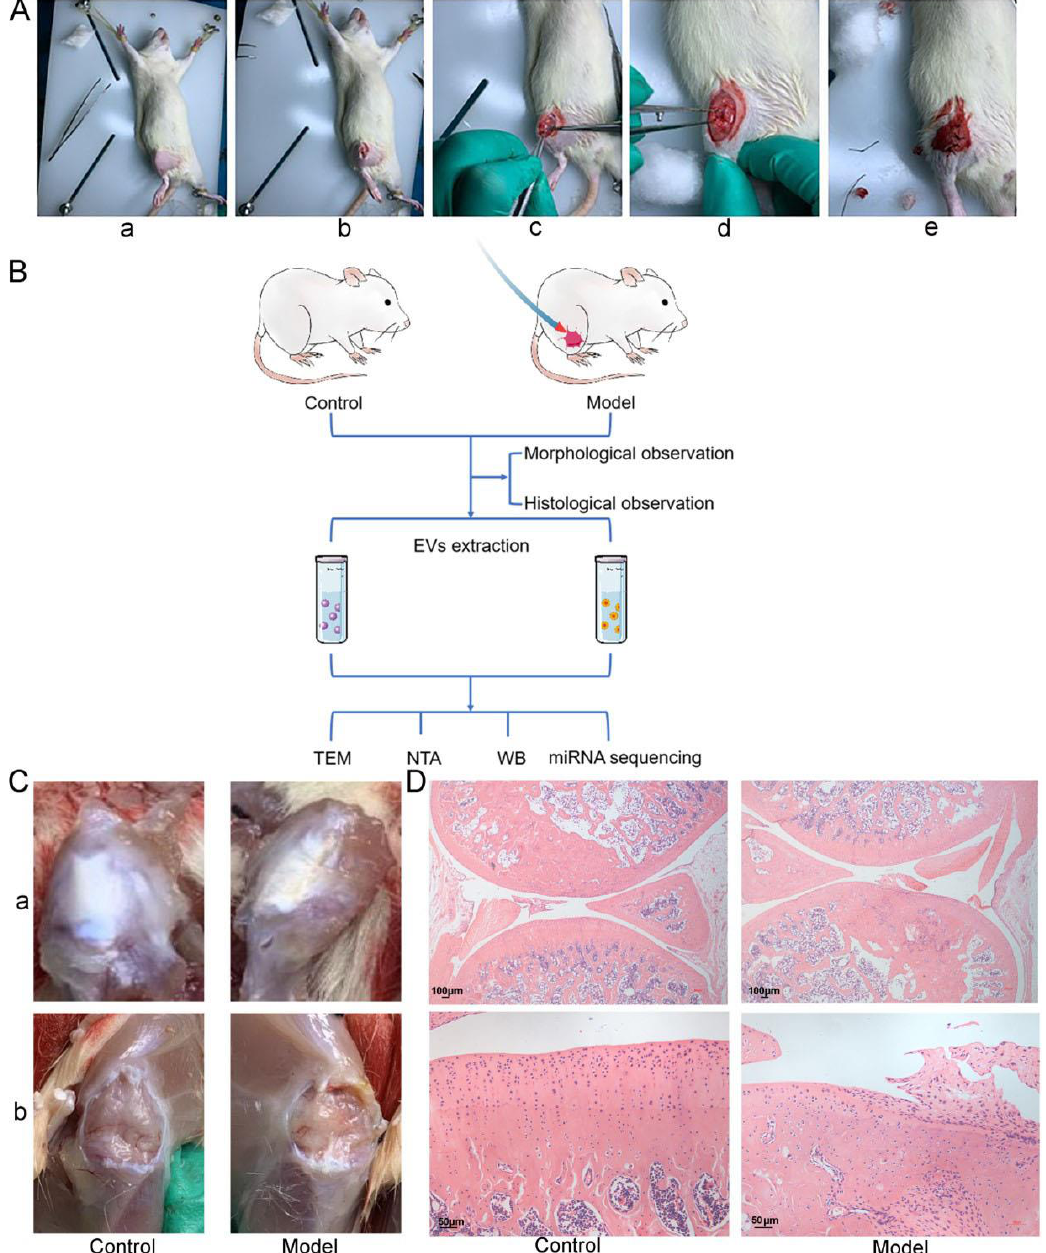
Figure 1. Construction and validation of a rat model of knee OA. ( A ) Establishment of OA model in rats by ALCT method. ( a ) The hair around the knee was removed to expose the surgical incision site. ( b ) After disinfection, the skin and various subcutaneous tissues were sequentially incised using a scalpel. ( c ) The knee joint capsule was exposed laterally. ( d ) The anterior cruciate ligament was cut. ( e ) The muscles, fascia, and skin were sequentially sutured. ( B ) The screening flow for the differentially available miRNAs between the circulating EVs of the control (healthy rats) and the model (OA rats) groups. The circulating EVs were extracted from serum using differential centrifugation, and TEM, NTA, and WB were used to identify the EVs. Then, miRNA sequencing was performed on these EVs. ( C ) Morphological observation. After the skin and subcutaneous tissues surrounding the knee, the knee joints were removed layer by layer. ( a ) The skin on the knee surface was opened. ( b ) Then, the joint cavity was opened, and the SM was exposed. ( D ) Histological observation. The entire knee joints were stained using HE.